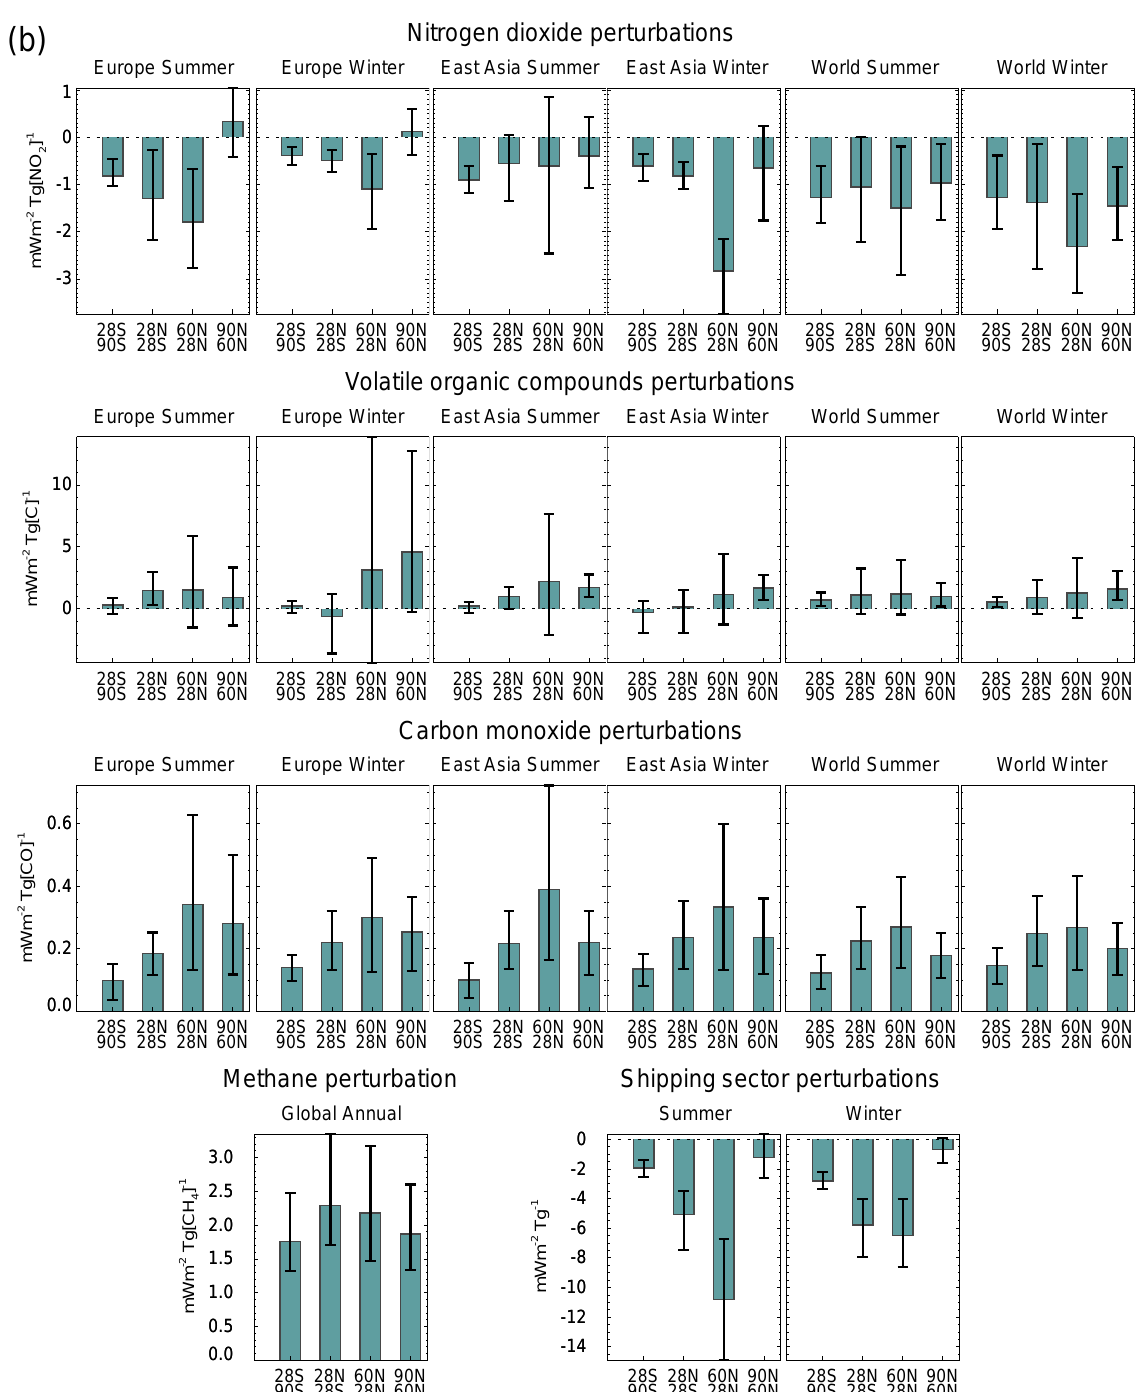
Figure 7. (a) Best estimates of annually averaged specific radiative forcing, in mWm − 2 (Tgyr − 1 ) − 1 , in four latitude bands, for aerosol primary and precursor emission perturbations. Each row corresponds to a perturbed species: (from top to bottom) sulfur dioxide, black carbon, organic carbon, and ammonia. Each column corresponds to a regional and seasonal perturbation. Bar charts are shown for four latitude bands, from left to right: 90–60 ◦ N, 60–28 ◦ N, 28 ◦ N–28 ◦ S, and 28–90 ◦ S. (b) As Fig. 7a but for ozone precursor and shipping sector perturbations. Perturbed species are, from top to bottom, nitrogen oxide, volatile organic compounds, carbon monoxide, methane, and all species emitted by the shipping